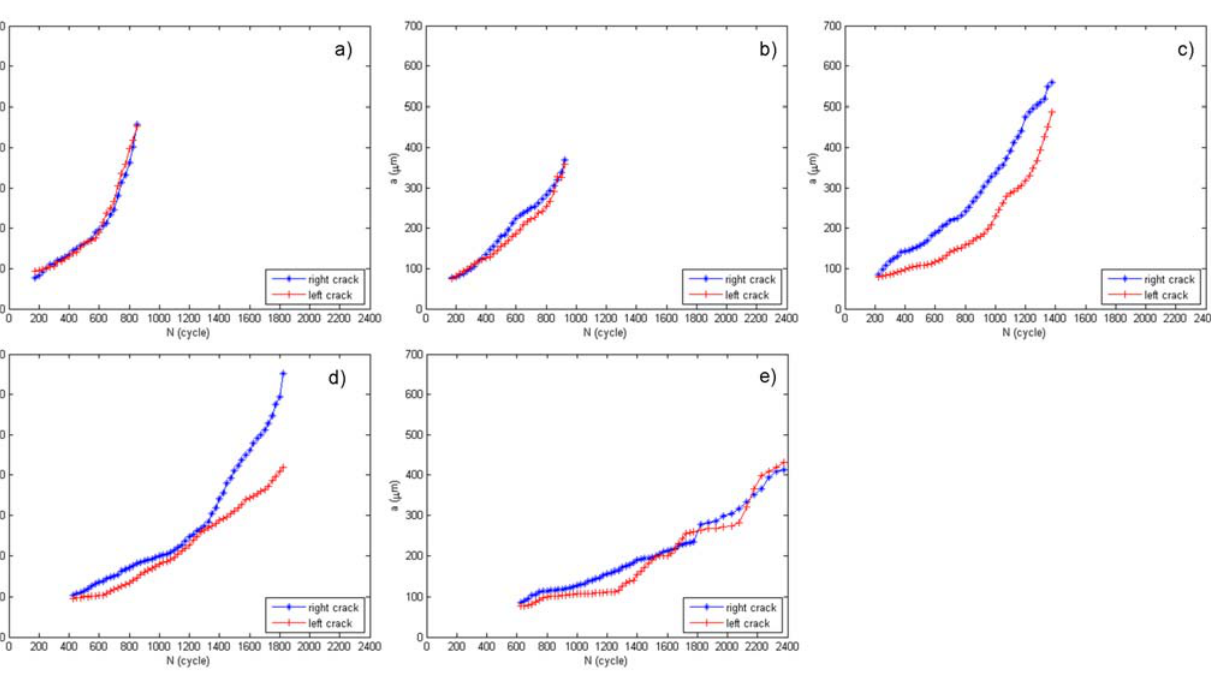
Figure 7: Crack length versus number of cycles for samples a) S1, b) S2, c) S3, d) S4 and e)